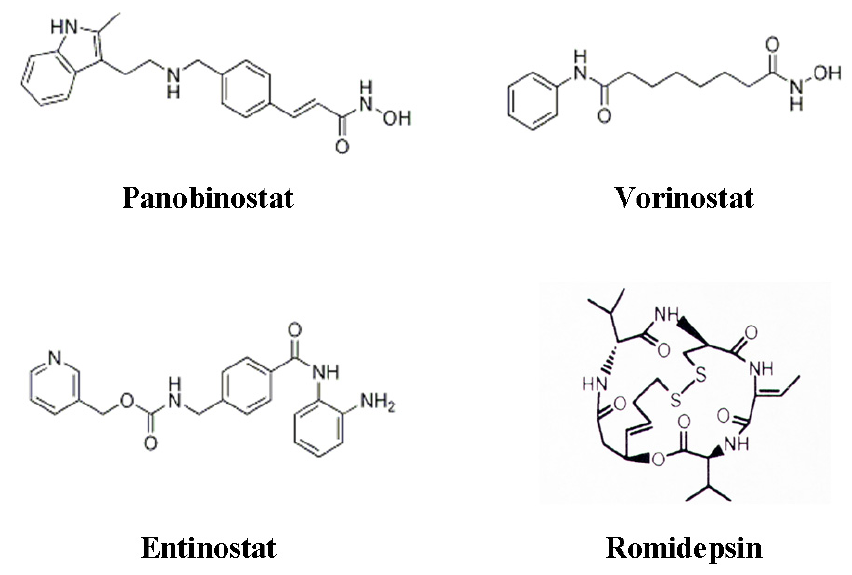
Figure 2. Chemical structures of clinically relevant HDAC